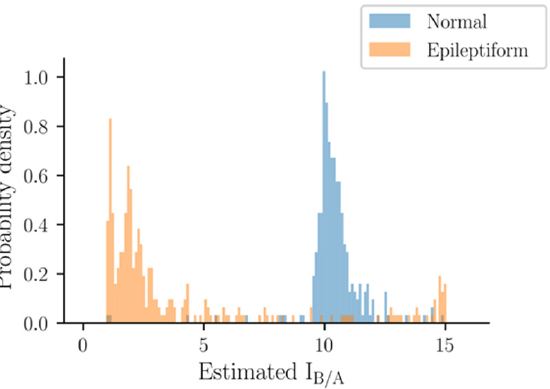
Figure 5. Estimated I B/A values of the experimental EEG data without electrical stimulation.